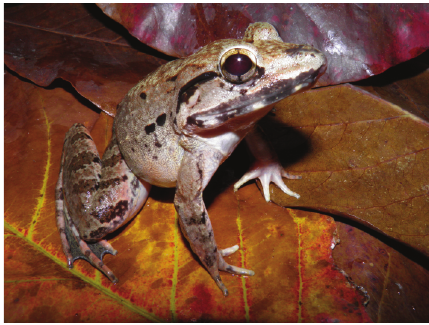
Figure 4: Inflation behaviour displayed by L. blythii .